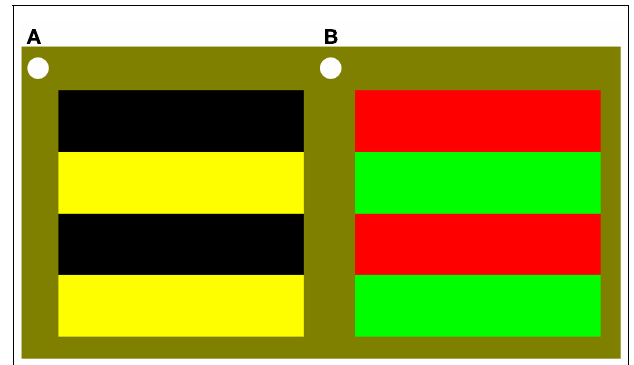
FIGURE 1 | Stimuli were 0.5 (as illustrated here), 3, or 6 cpd, horizontal, stationary, square-wave gratings (4˚ × 4˚) that were either (A) black/yellow; or (B) perceptually isoluminant red/green.